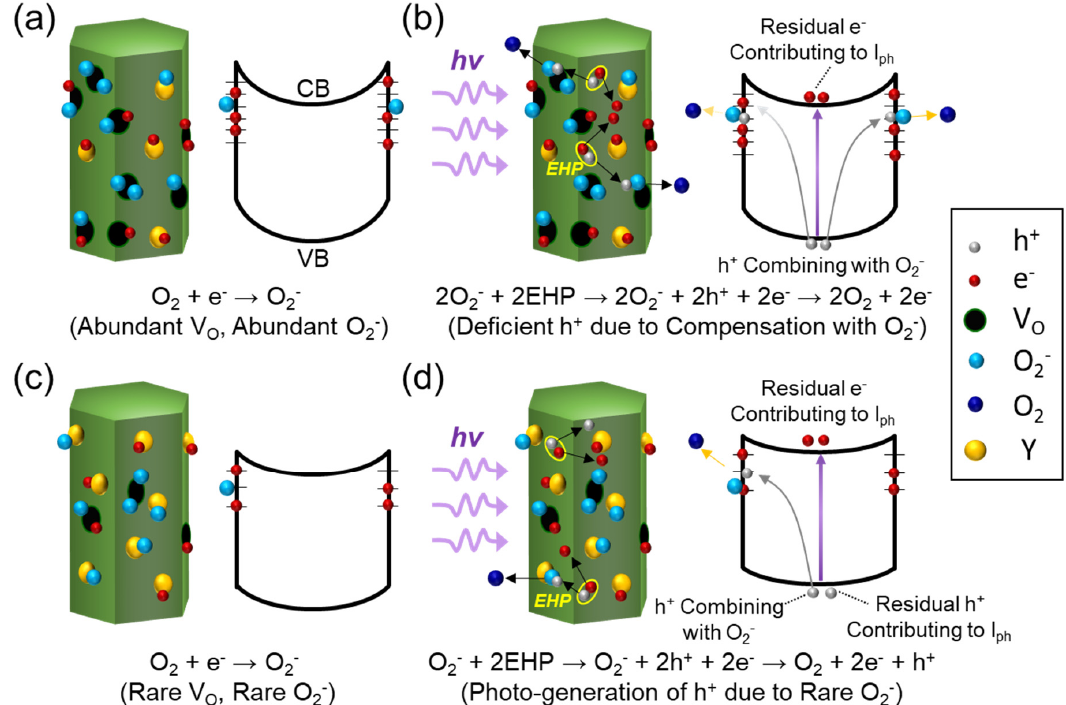
Figure 4. Schematic illustrations of the YZO-NR surface (left-hand-side) and its corresponding energy band diagram (right-hand-side): Defective YZO-NR with a lower Y concentration at ( a ) dark and ( b ) UV illumination, and less-defective YZO-NR with a moderate Y concentration at ( c ) dark and ( d ) UV illumination. The chemical formula in each figure denotes the chemical reaction under the given situation.